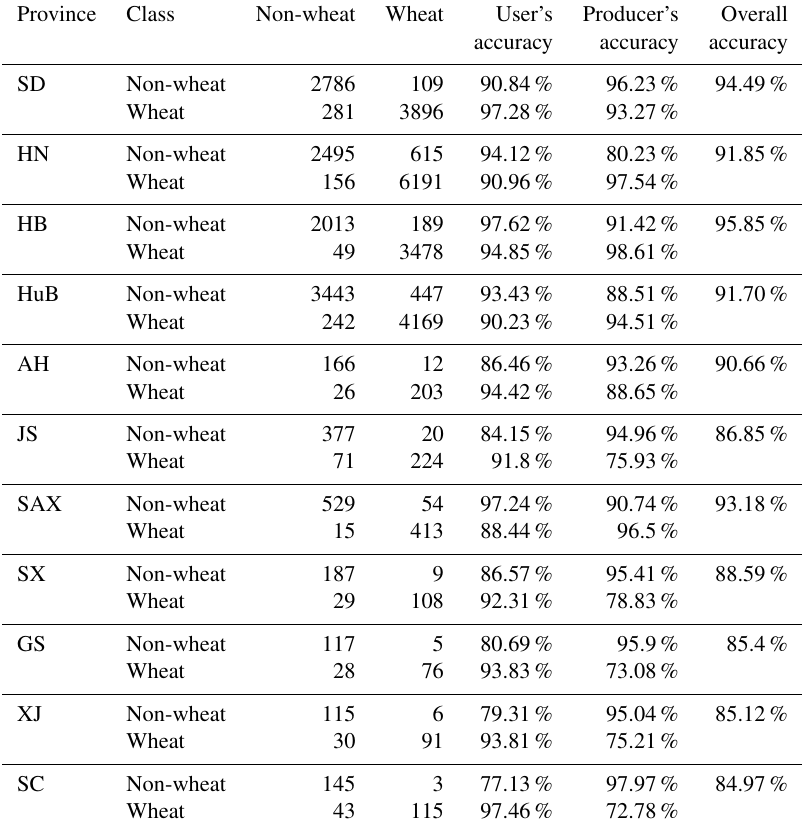
Table 2. Confusion matrix for the identification map of planting areas of winter wheat in 11 provinces during